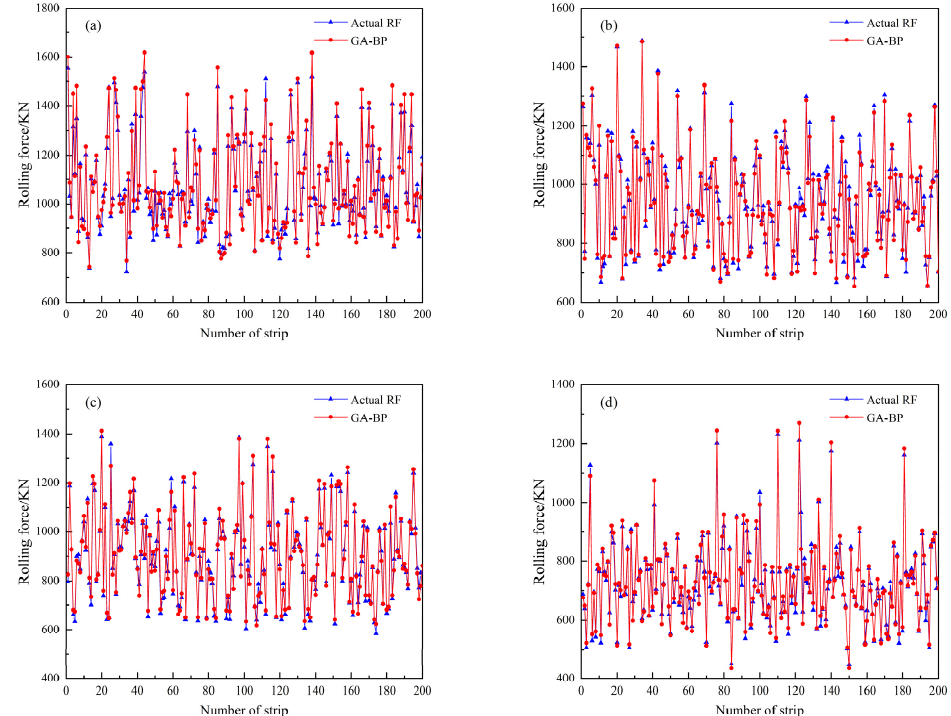
Figure 10. Comparison of the rolling force between the actual value and preset value: ( a ) S1 stand, ( b ) S2 stand, ( c ) S3 stand, ( d ) S4 stand. Table 2. Comparison of rolling force qualification rate,